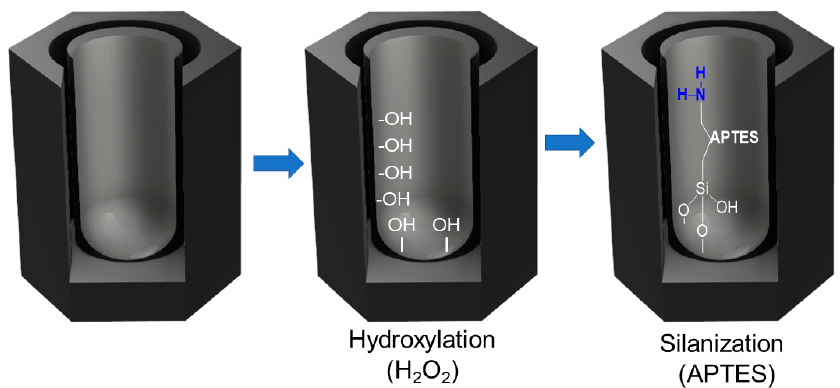
Figure 1. Schematics of the immobilization of APTES into the pores of NAA.